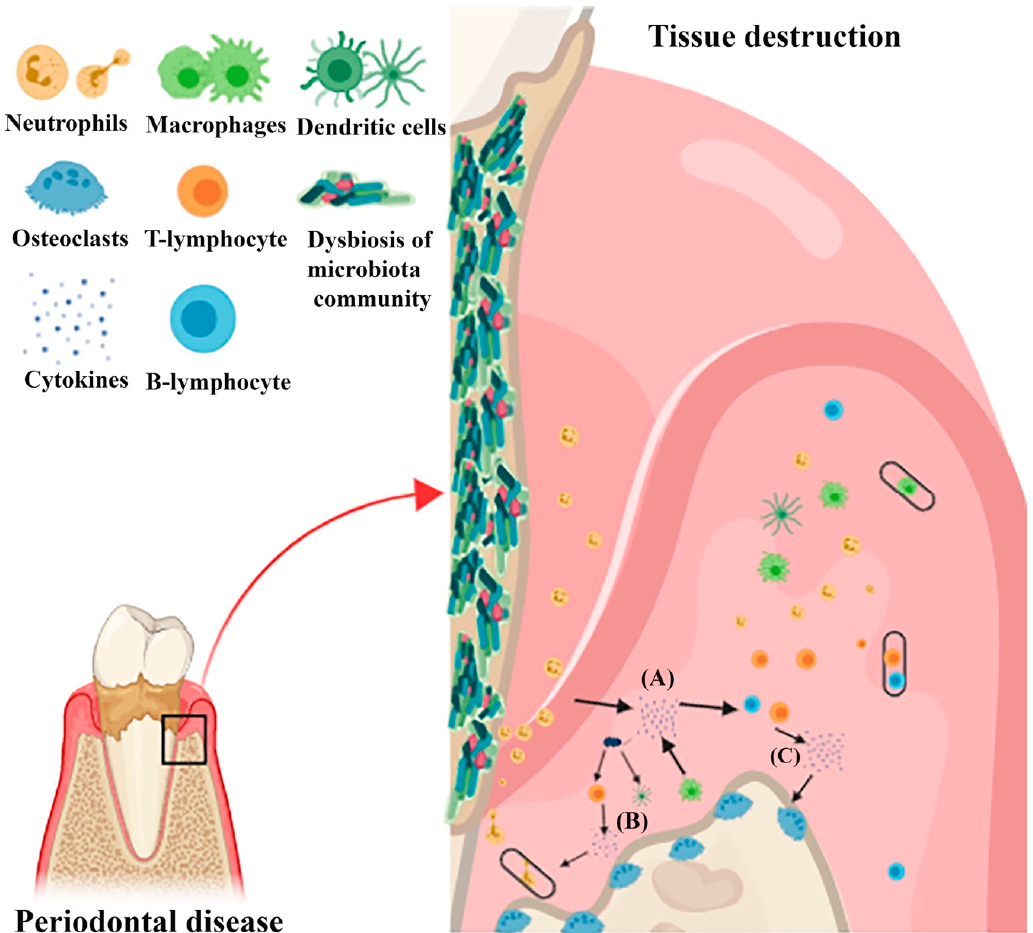
Figure 1. Diagrammatic illustration depicting pathogenicity of periodontitis and the interplay of cytokines involved. Pathogenicity of locally present microbiota is enhanced by the colonization of pathogens, thereby over activating the immune response and triggering tissue destructions. ( A ) The first wave of cytokine secretions that takes part in amplifying the pro-inflammatory cytokine cascade and aid in recruitment, activation, and di ff erentiation of specific immune cells is shown. ( B ) Additionally, a group of cytokines closely correlated to di ff erentiation of a specific subset of lymphocytes are secreted by mononuclear phagocytes and antigen presenting cells after stimulation by microbiome. ( C ) Each of these cells releases a certain pattern of cytokines which might act as the positive feedback loop, finally leading to destruction of the tissue.